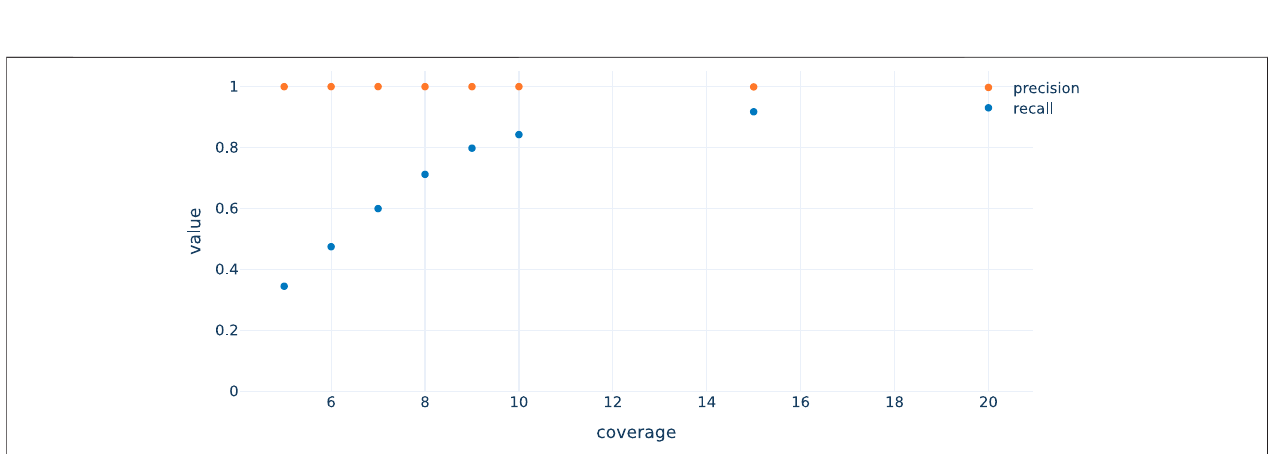
FIGURE 4 | Recall and precision by coverage for data simulated as described in the main text. Recall improves with increasing coverage while precision is optimal independent of the